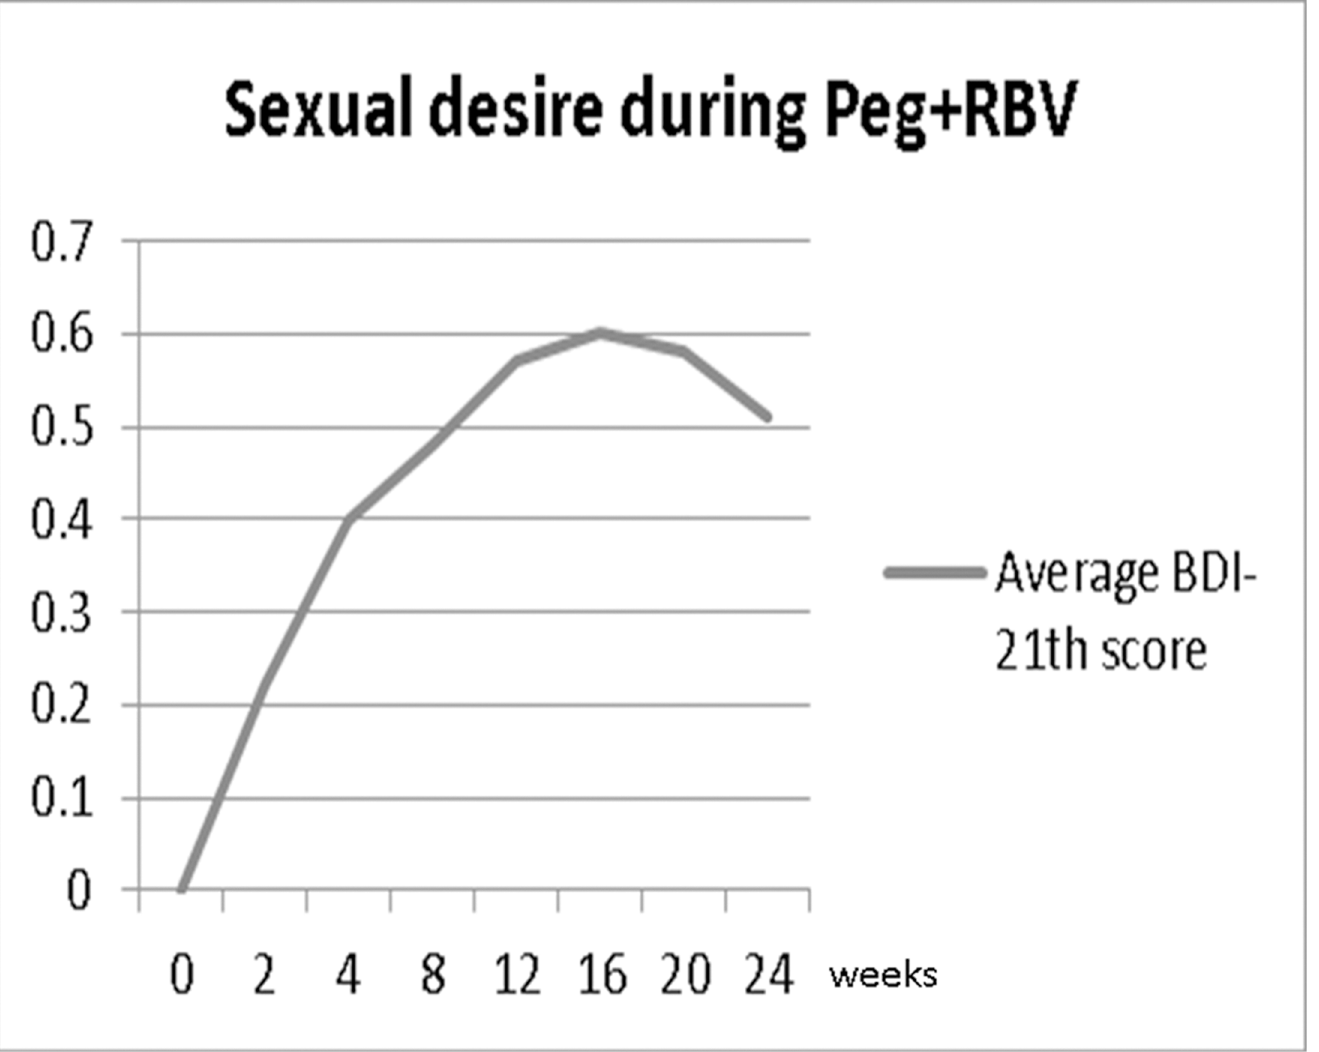
Fig 2. Time course of the 21-item Beck Depression Inventory (BDI) scores and BDI scores of decreased sexual desire in hepatitis C patients before (week 0) and during anti-viral therapy. The higher values represented greater deterioration.